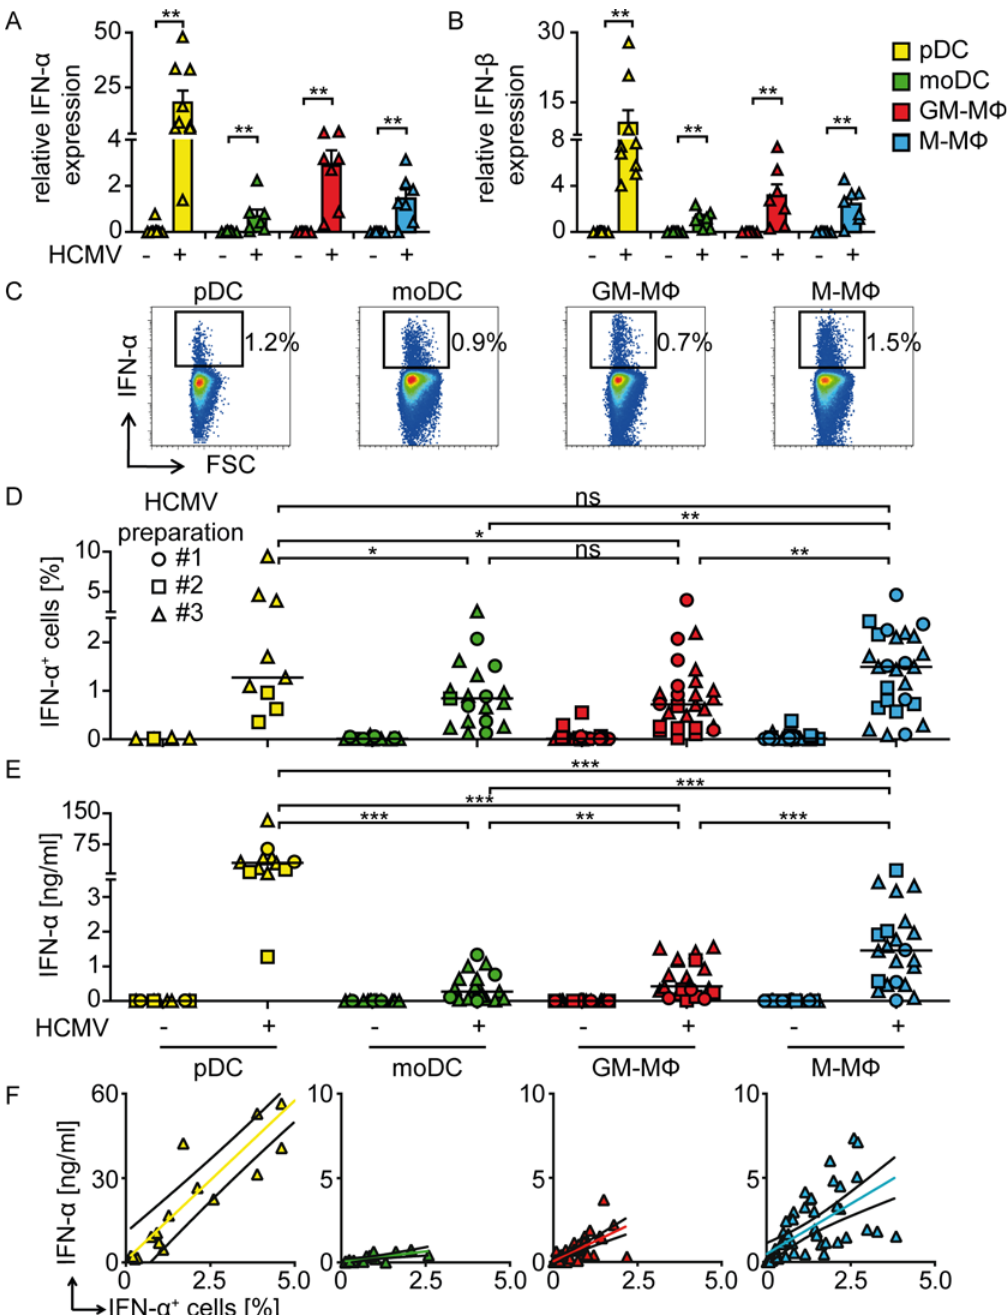
Fig 2. HCMV infection induces IFN-I responses in pDC as well as monocyte-derived DC and M Φ . pDC, moDC, GM-CSF M Φ , and M-CSF M Φ were infected with HCMV at MOI 3 and 24 hours post infection (hpi) (A) IFN- α and (B) IFN- β mRNA expression was determined relative to HPRT1 mRNA by qPCR (mean ± SEM of 7 – 9 different donors). (C, D) IFN- α expressing cells were analyzed by flow cytometry and (E) the IFN- α content in cell-free supernatants was determined by an ELISA method upon infection with three independently produced HCMV preparations (#1, #2, and #3) at MOI 3. (F) Upon HCMV infection with varying MOI between 0.1 to 30 IFN- α concentrations in cell-free supernatants (y-axis) were blotted against percentages of IFN- α + cells (x-axis) of the same culture (Values from 12 – 28 different donors. Black line: confidence interval of 95%). Median of 9 – 26 (D) and 12 – 23 (E) different donors. ns = not significant, * : p (cid:1) 0.031, ** : p (cid:1) 0.0078, *** : p (cid:1) 0.0002 one-tailed paired Wilcoxon signed rank test was used for statistical analyses between monocyte- derived cell subsets, because the subsets were derived from monocytes of the same donors. In contrast, pDC were derived from different donors. Therefore, statistical analysis between pDC and one of the monocyte-derived cell subsets was performed using one-tailed unpaired Mann-Whitney test.